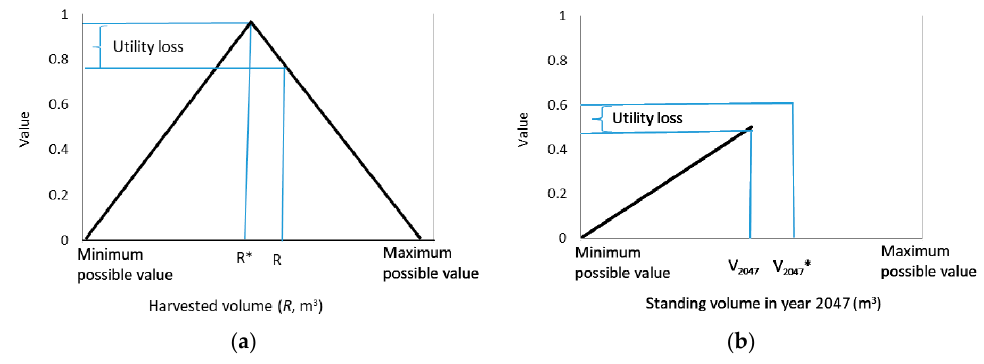
Figure 4. Utility losses for the case of ending volume ( a ) and harvested volume ( b ). V 2047 * and R * represent, respectively, the growing stock volume at the end of the plan and the harvested volume during each 10-year period, obtained based on the Reference Inventory data when optimization results are also based on Reference inventory . V 2047 and R are the corresponding values obtained when the Reference Inventory data are used with optimization results based on erroneous data (i.e., with plot positioning errors).